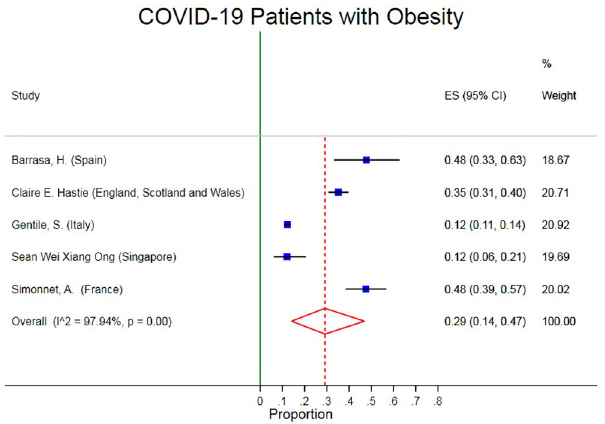
Fig 2. Forest plots of pooled prevalence of obesity in Covid-19 patients.